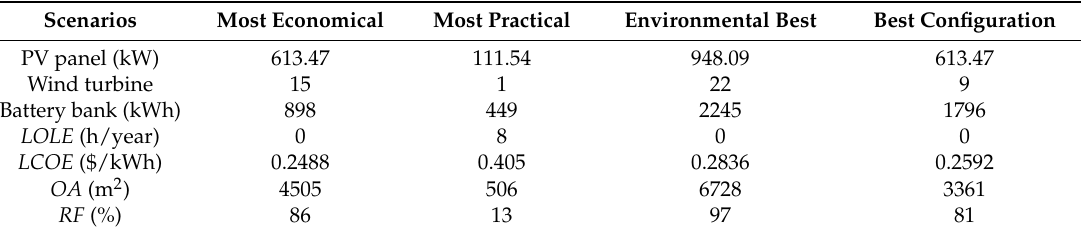
Table 6. Simulation results of different scenarios and the best